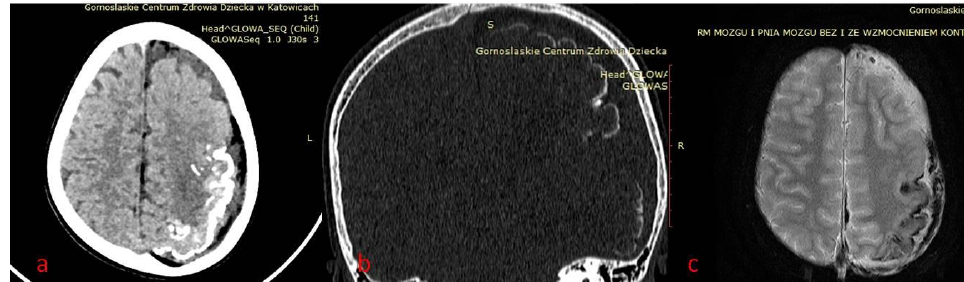
Figure 3. ( a – c ) Patient 1. Brain CT—left parietal and temporal gyral calcifications. ( a , b ) CT in axial brain window and coronal reformatted bone window; ( c ) MRI SWI sensitive to calcium/blood metabolites.